Question: What does this figure show? Answer in one sentence.
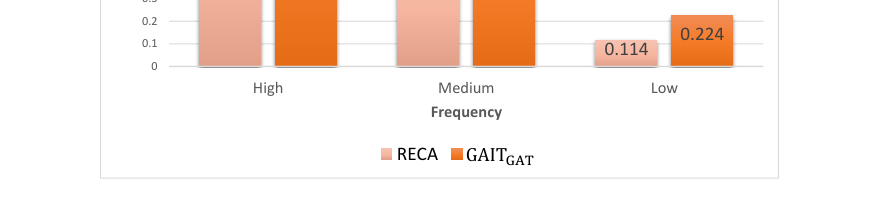
Answer: The macro f-score of GAITGAT and RECA on Semtab dataset, for High, Medium, and Low-frequency classes.